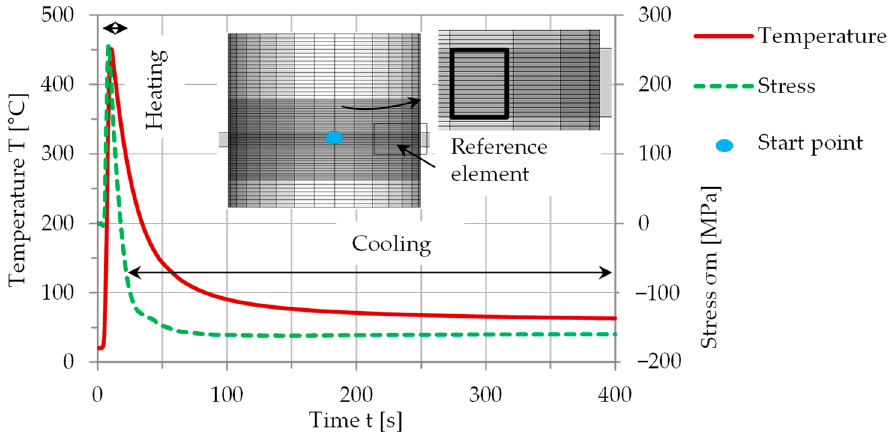
Figure 15. Stress and the temperature history on the tool surface in typical weld-cladding simulation (A4 bead).